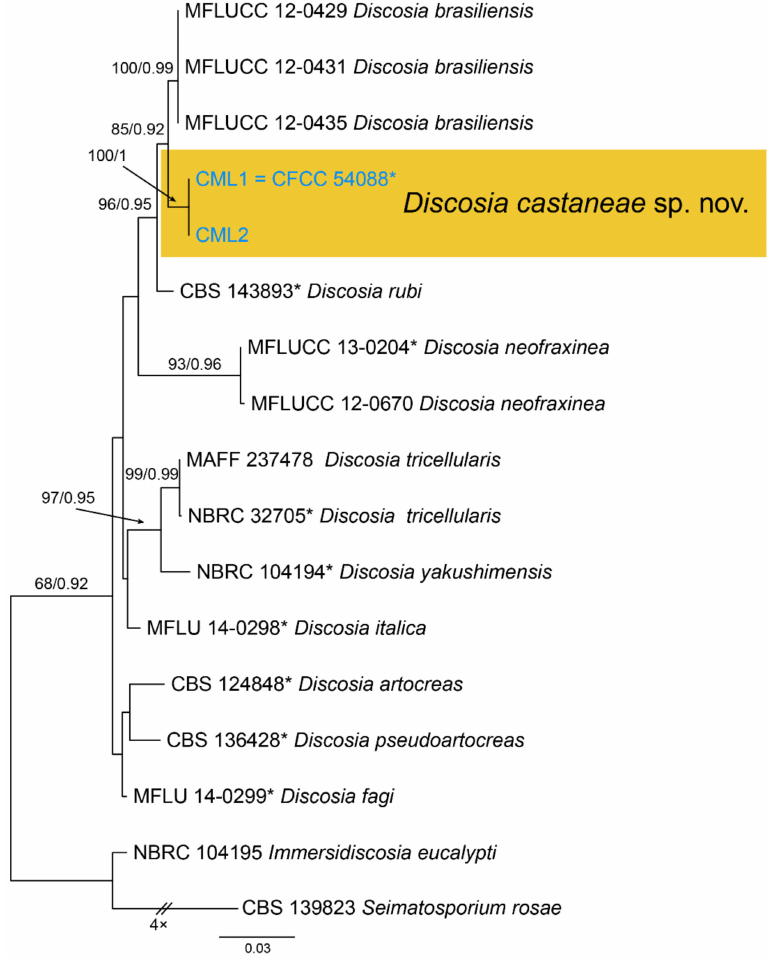
Figure 9. Phylogram generated from RAxML analysis based on combined ITS, LSU and tub2 sequence data of Discosia isolates. The tree was rooted to Immersidiscosia eucalypti (CBS 544.95) and Seimatosporium rosae (CBS 139823). The scale bar indicates 0.03 nucleotide changes per site. Isolates from this study are marked in blue, ex-type strains are marked with *, and the identified species is marked in